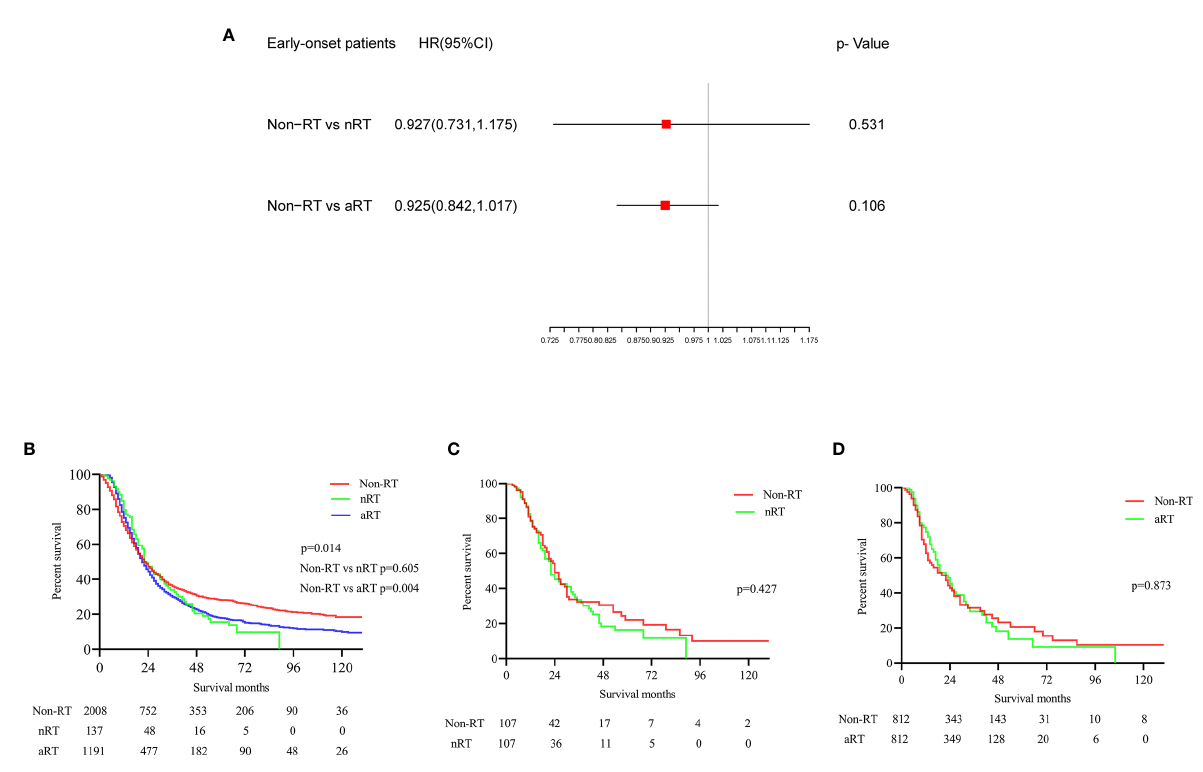
FIGURE 2 | The forest plot and the survival curves were used to demonstrate the effect of radiotherapy in early onset stage IIB/III PDAC patients. (A) . The forest plot for non- RT vs. nRT and non-RT vs. aRT in early onset stage IIB/III PDAC patients; (B) . The survival curve for total early onset stage IIB/III PDAC patients before PSM; (C) . The survival curve for non-RT vs. nRT in early onset stage IIB/III PDAC patients after PSM; (D) . The survival curve for non-RT vs. aRT in early onset stage IIB/III PDAC patients after